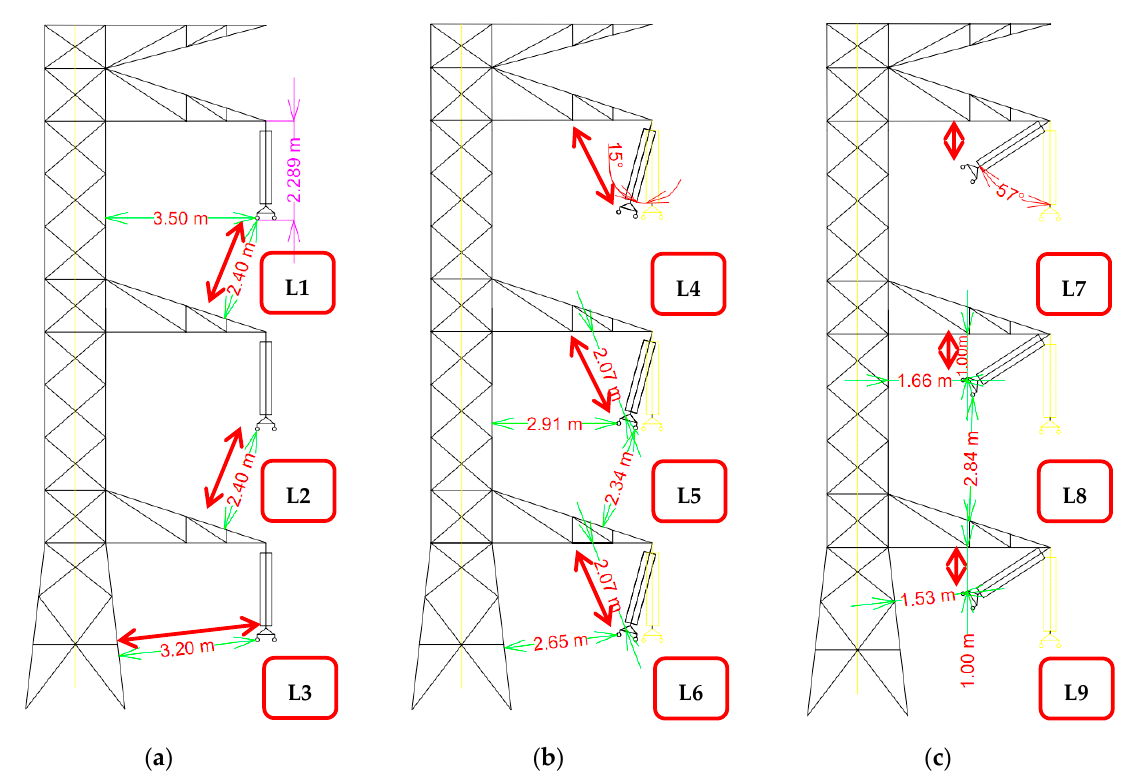
Figure 8. The minimum phase-to-earth electrical clearances under ( a ) still air, ( b ) normal wind, and ( c ) extreme wind conditions.